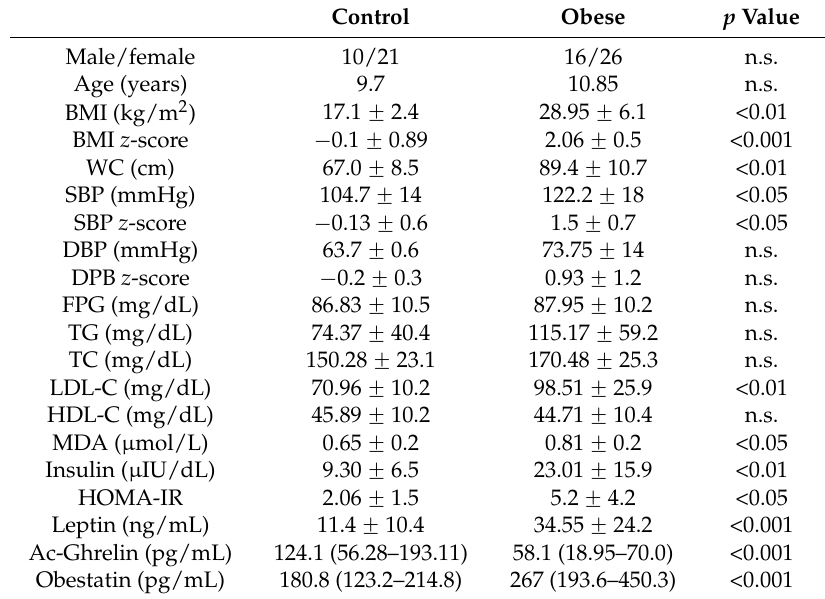
Table 1. Anthropometric and biochemical characteristics of obese and non-obese children and adolescents. Control Obese p